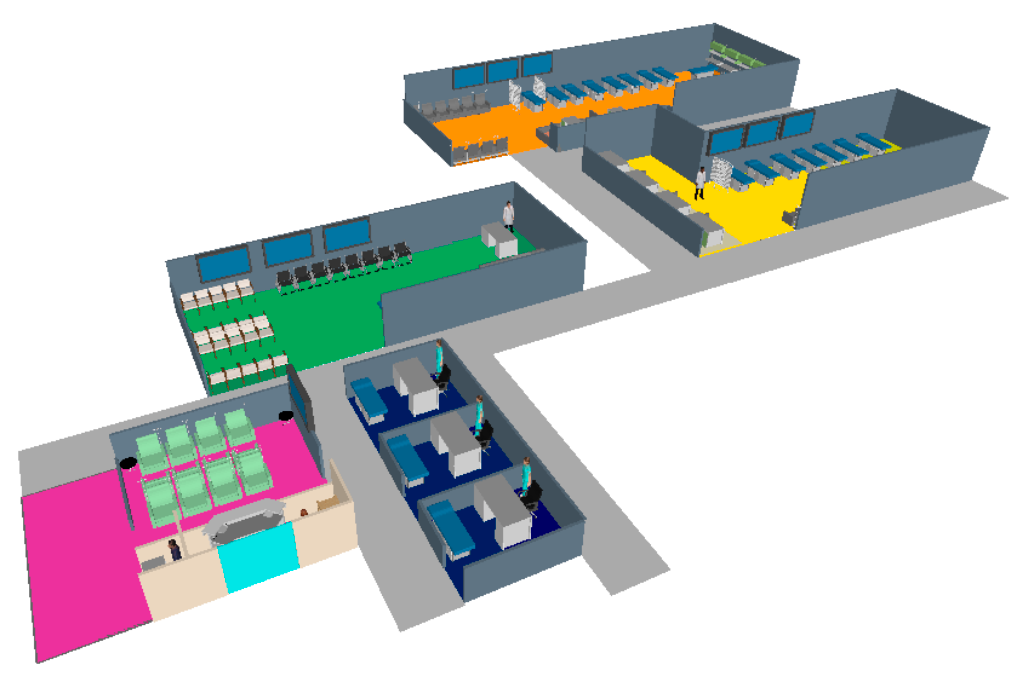
Figure 11. Overview of the simulation model (purple area — admission, blue area — triage, green area — green and blue treatment room, yellow area — yellow treatment room, orange area — orange treatment room).